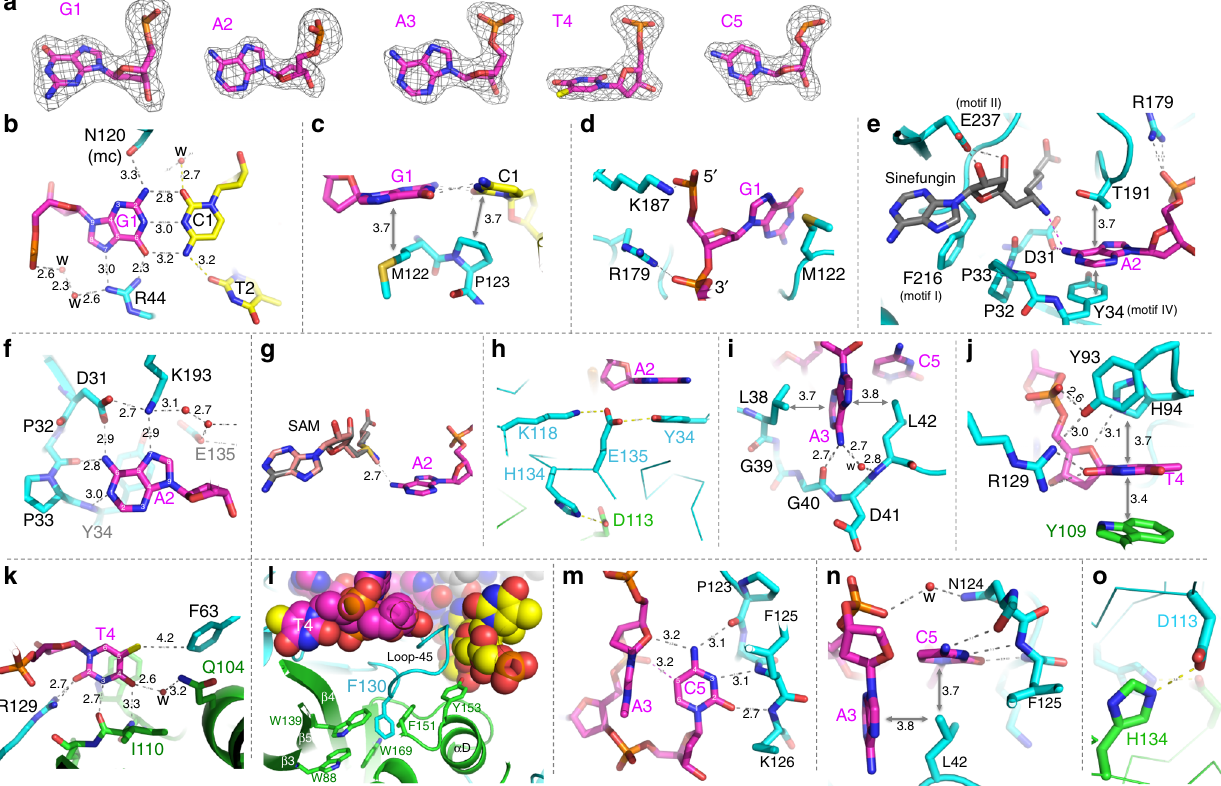
Fig. 4 Base speci fi c recognition of target strand. a The omit electron density (Fo-Fc), contoured at 5.0 σ above the mean, for omitting each individual nucleotide of the target sequence. b , c Interactions with G1:C1 base pair. Interatomic distances are shown in angstroms. d Arg179 and Lys187 of Loop-6E interact with phosphate groups fl anking G1. e , f Interactions with the target adenine A2 in the active-site pocket. g Superimposition of methyl donor SAM onto sinefungin. h A network of interactions involving Lys118, Glu135, and Tyr34 in stabilization of target base A2. i Interaction with the variable position of A3 in GANTC (N = any nucleotide). j , k Interactions with thymine T4. l CcrM dimer interaction involving Phe130 of molecule B (cyan) and an aromatic cage of molecule A (green). m , n Interactions with cytosine C5. o Two pairs of H134-Asp113 interactions in the dimer